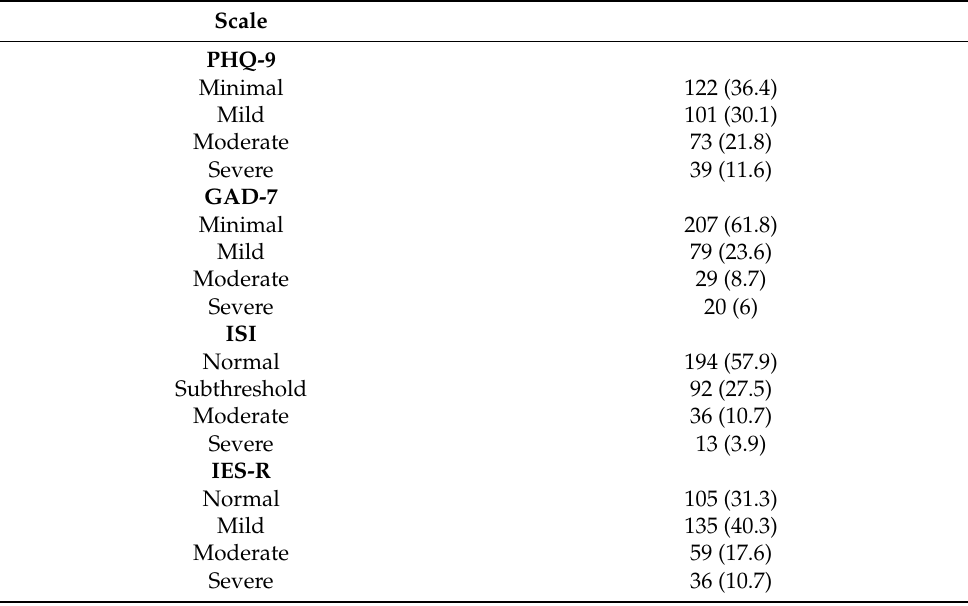
Table 2. Mental health status of participants according to different scales used.